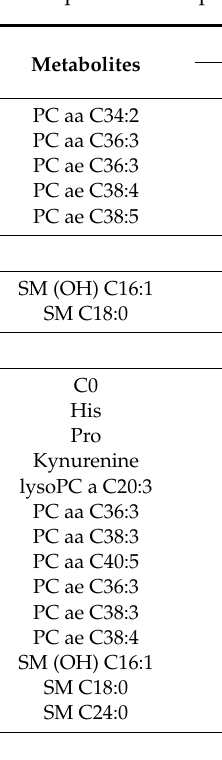
Table 2. Metabolites a ff ected by CCRT and RT. Presented are metabolites that changed their levels significantly (FDR < 0.05) between specified time points in both treatment